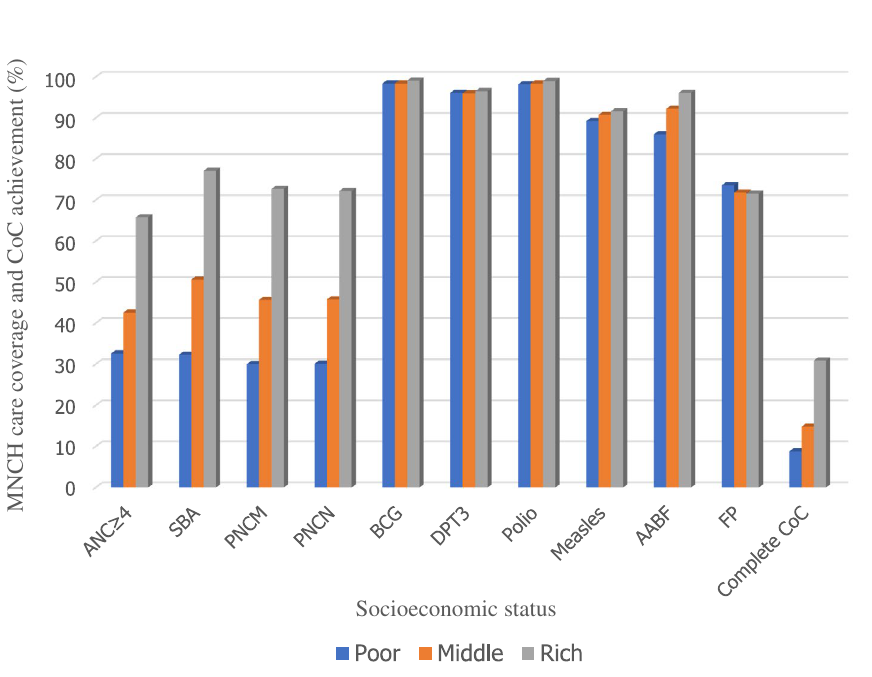
Figure 2. Percentage distribution of MNCH care coverage and CoC achievement by SES.